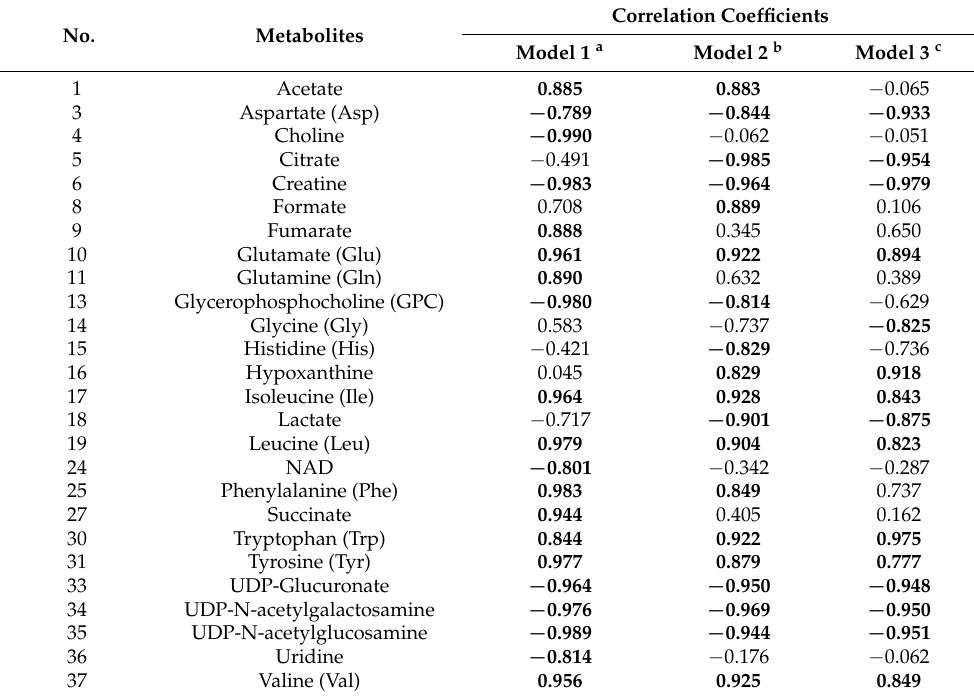
Table 1. Correlation coefficients from OPLS-DA analysis for significantly changed metabolites in corresponding cells supplemented with SeMet under different Met supply conditions.